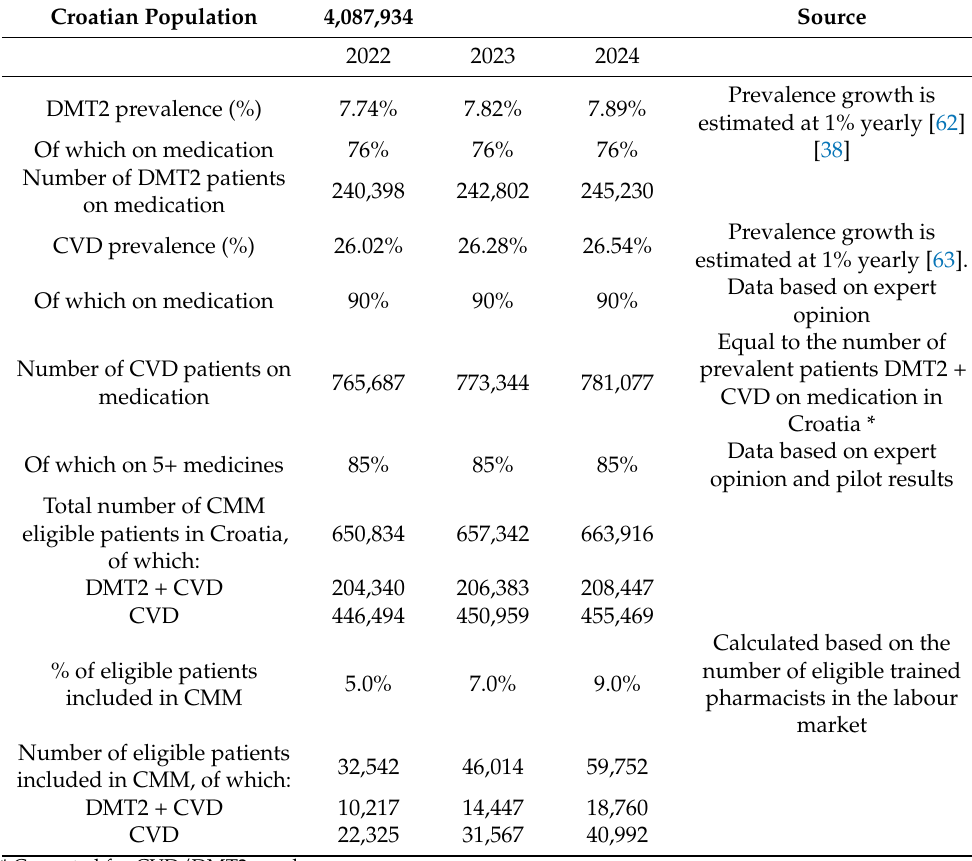
Table 2. Eligible population and the number of patients in